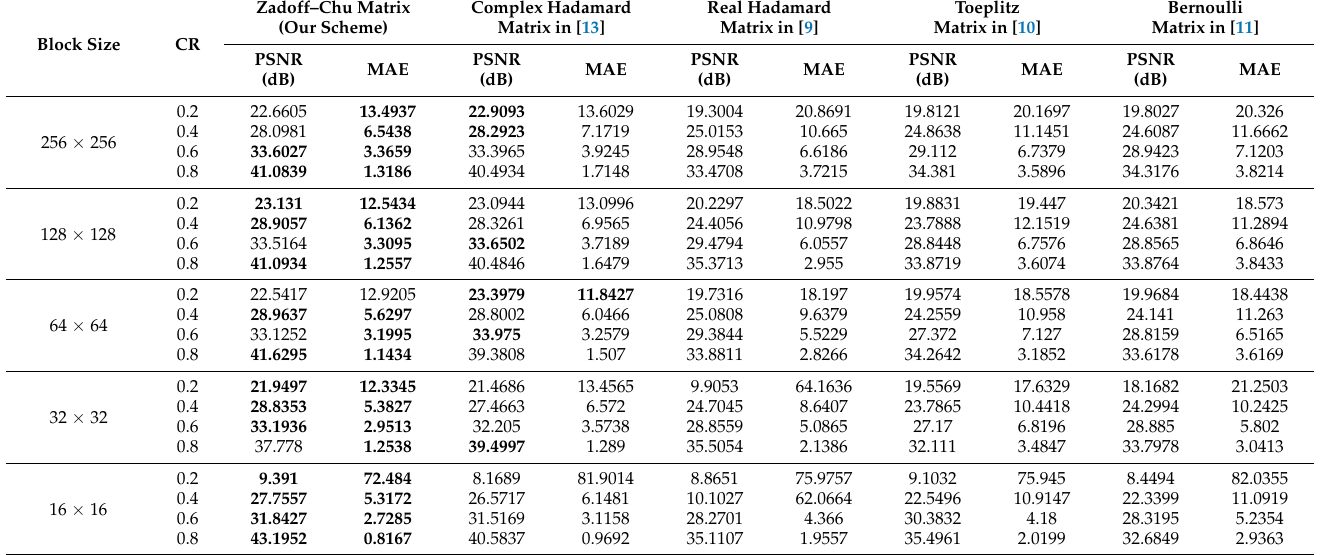
Table 3. Comparison of reconstruction performance between different measurement matrices for “Lena” image based on SL0 reconstruction algorithm. The bold indicates the best PSNR value and MAE value of each